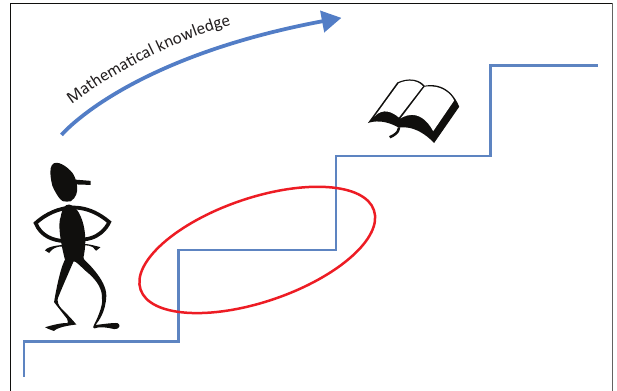
FIGURE 3: Cumulative structure of learning